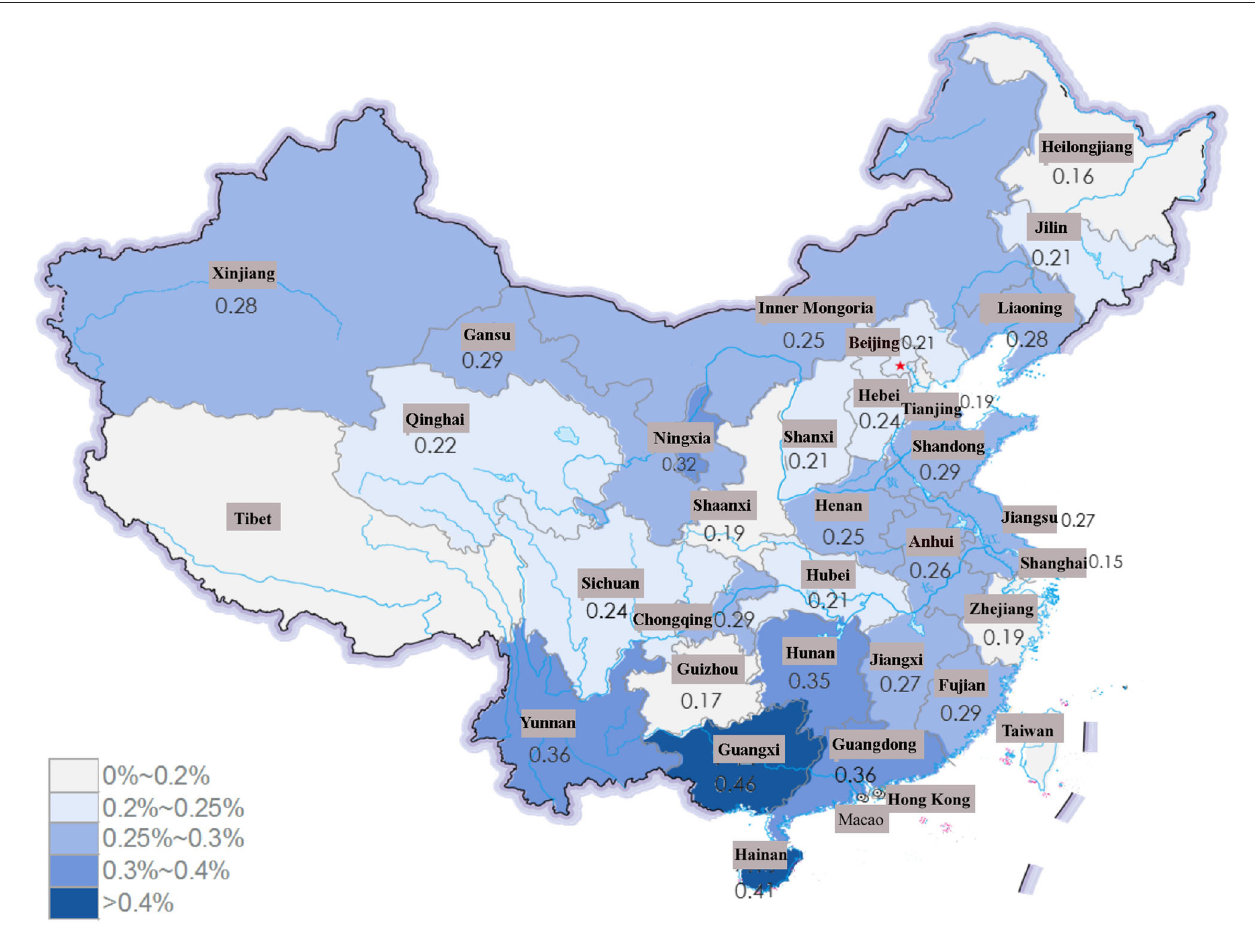
FIGURE 3 | The frequency of SLE among all the patients in HQMS in province of China in 2017. The frequency of SLE was much higher in Guangxi Province, Hainan Province and Guangdong Province (0.46, 0.41, and 0.36%,